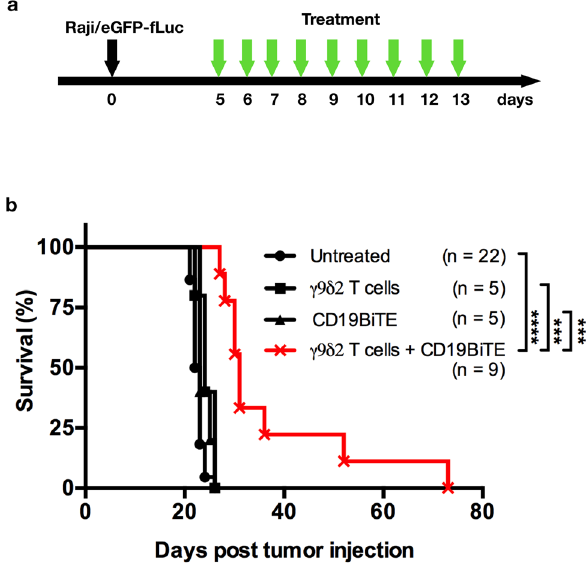
Figure 5. Adoptive transfer of γ9δ2 T cells enhances CD19BiTE’s antitumor activity in CD19 + tumor xenograft-bearing mice. ( a ) Schematic representation of the experimental schedule. ( b ) Kaplan–Meier survival curves. Adult NOG mice (16–18 weeks old, male; n = 41) were intravenously (i.v.) inoculated with human Raji/eGFP-fLuc tumor cells (2.5 × 10 5 cells/mouse). On day five post tumor inoculation, mice received daily treatment of a dose of γ9δ2 T cells (2.5 × 10 6 cells/mouse, i.v.; n = 5) or two doses of CD19BiTE (250 ng/ dose/mouse, i.v.; n = 5) alone, or both (n = 9) for nine consecutive days. Untreated animals serve as controls (n = 22). Survival, the days after tumor inoculation, was followed up. γ9δ2 T cells were expanded from two donors’ peripheral blood mononuclear cells. A single mouse was treated with the γ9δ2 T cells derived from the same donor at different time points. Survival curves were analyzed using the Log-rank (Mantel-Cox) test. ***: p = 0.0002; ****: p < 0.0001. : no treatment; ■ : treatment of γ9δ2 T cells; ▲ : treatment of CD19BiTE; ✖ : combination treatment of γ9δ2 T cells + ●